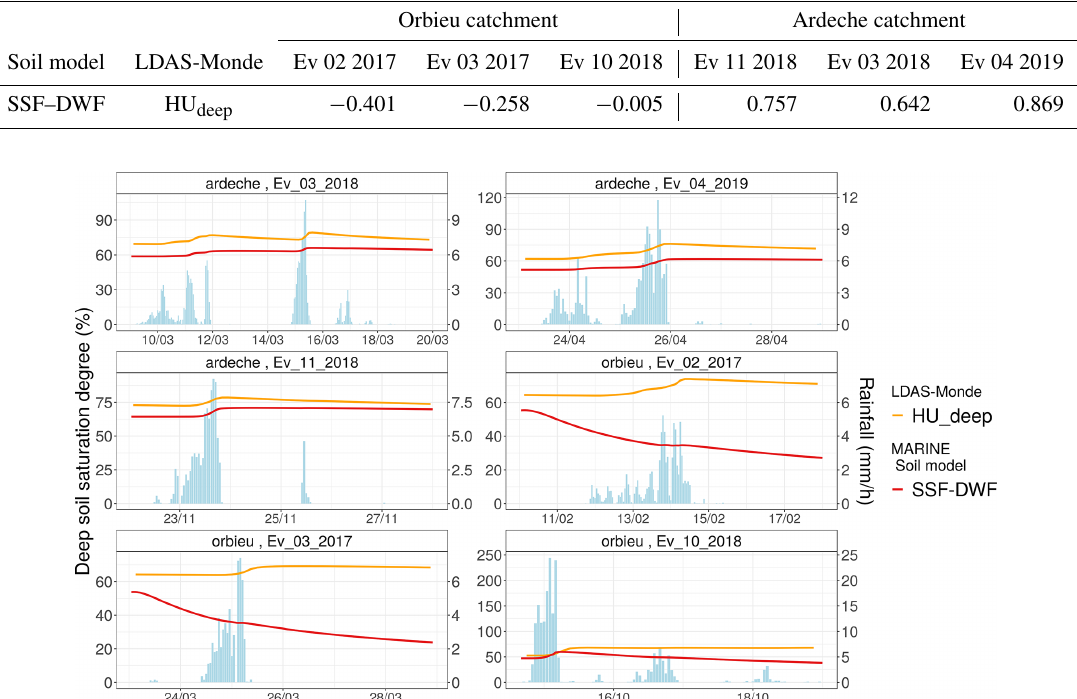
Table 7. Kendall correlations between the LDAS-Monde HU deep and deep layer moisture simulated with MARINE using the SSF–DWF model.